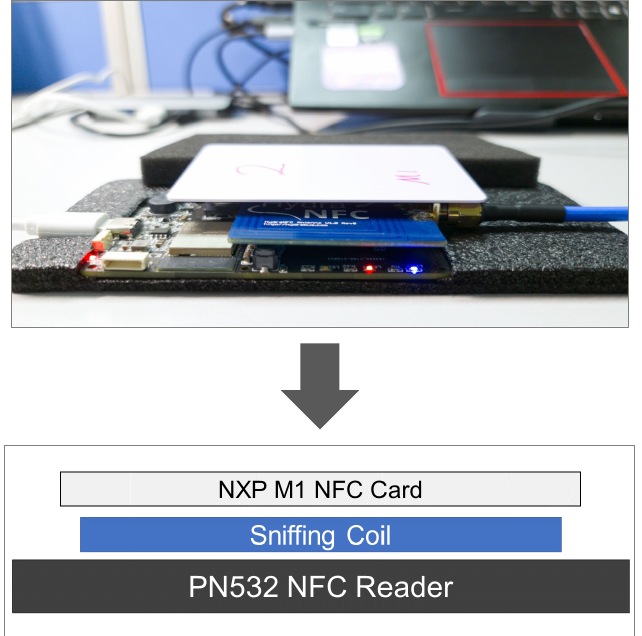
Figure 2. The experimental environment and the used SDR